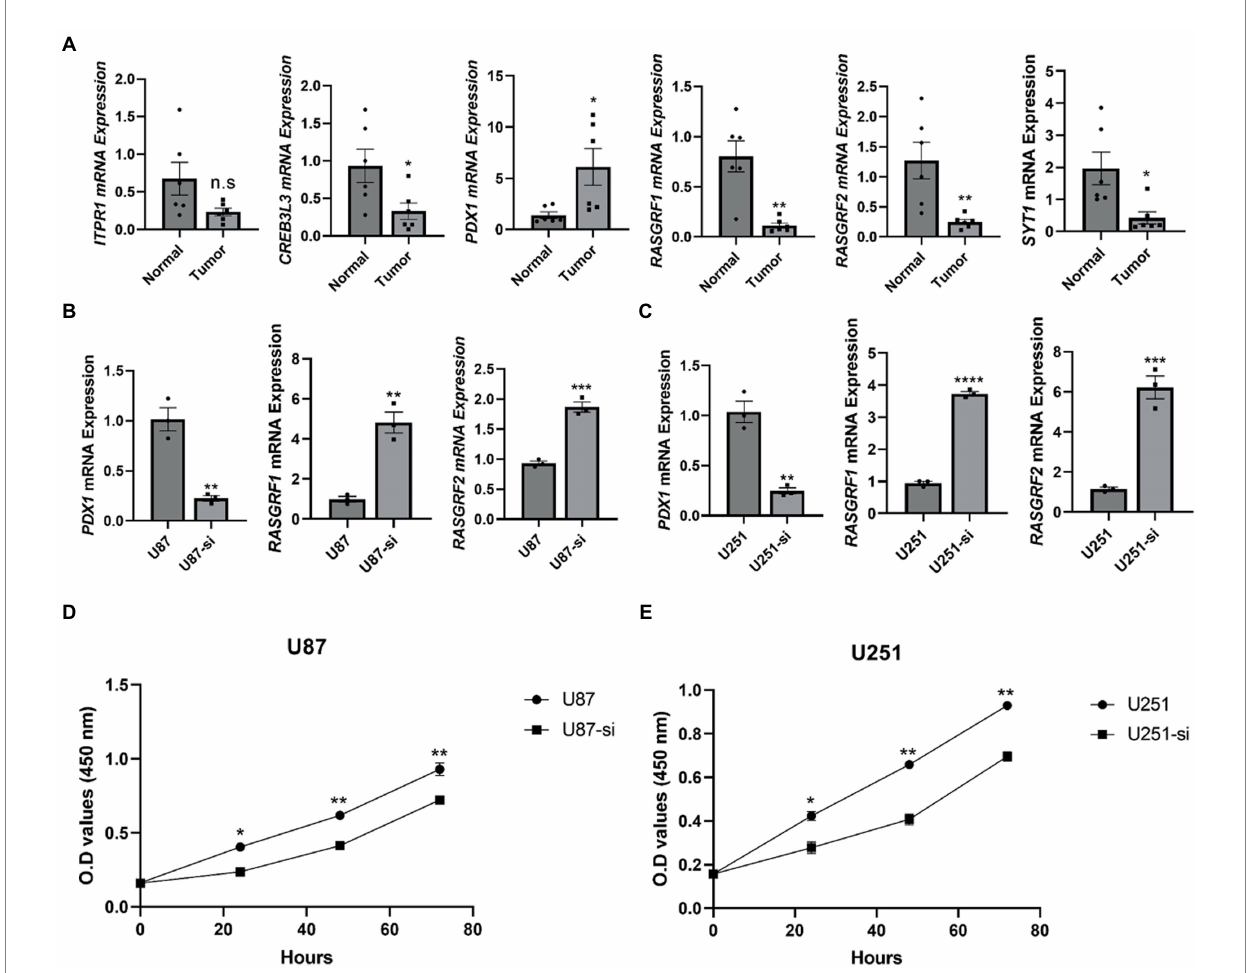
FIGURE 17 Imbalance of oxidative stress in glioma tissue compared to normal tissue. (A) The mRNA levels of ITPR1 , CREB3L3 , PDX1 , RASGRF1 , RASGRF2 , and SYT1 were measured and quantified in normal and tumor tissues ( n = 6); (B) The mRNA levels of PDX1 , RASGRF1 , and RASGRF2 were measured and quantified in U87 cell line after interfering with the expression of TMEM131L ( n = 3); (C) The mRNA levels of PDX1 , RASGRF1 , and RASGRF2 were measured and quantified in U251 cell line after interfering with the expression of TMEM131L ( n = 3); (D) Detection of cell viability after interference with TMEM131L expression in the U87 cell line ( n = 3); (E) Detection of cell viability after interference with TMEM131L expression in the U251 cell line ( n = 3). n.s > 0.05, * p ≤ 0.05, ** p ≤ 0.01, *** p ≤ 0.001, and **** p ≤